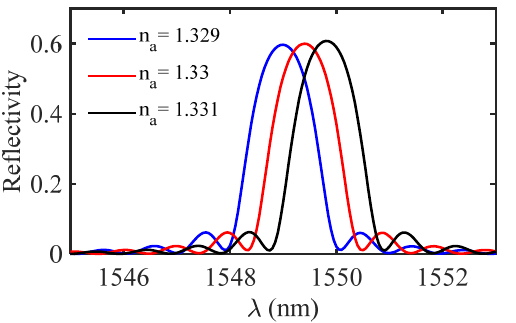
Figure 7. Reflected spectrum of the proposed HI-MCRW structure for three different ambient RIs.